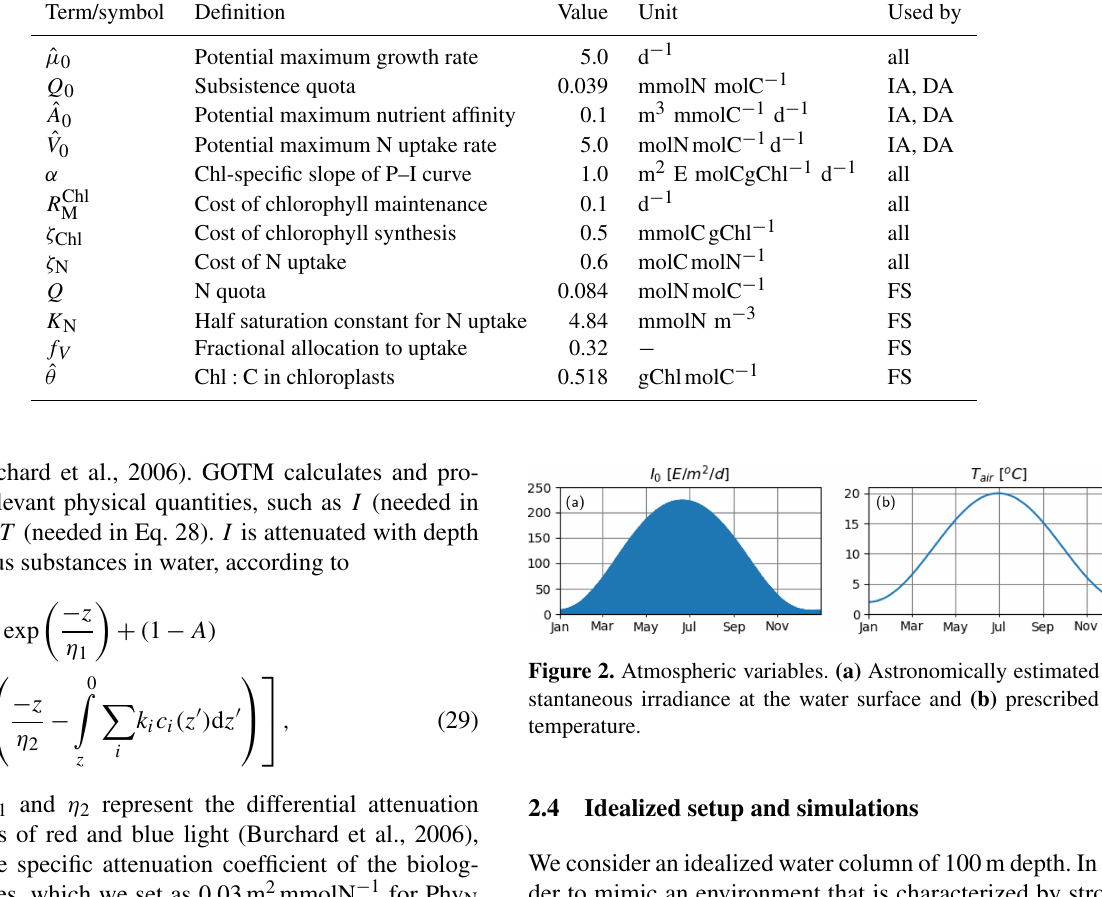
Chl-specific slope of P–I curve